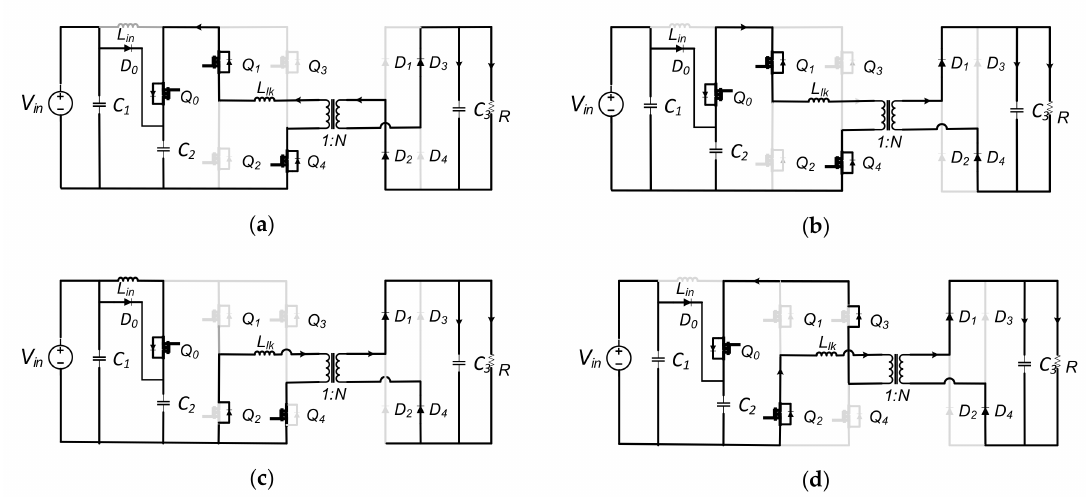
Figure 7. Circuit flow paths of step-down mode. ( a ) Stage 1 [ t 0 − t 1 ]; ( b ) Stage 2 [ t 1 − t 2 ]; ( c ) Stage 3 [ t 2 − t 3 ]; ( d ) Stage 4 [ t 3 − t 4